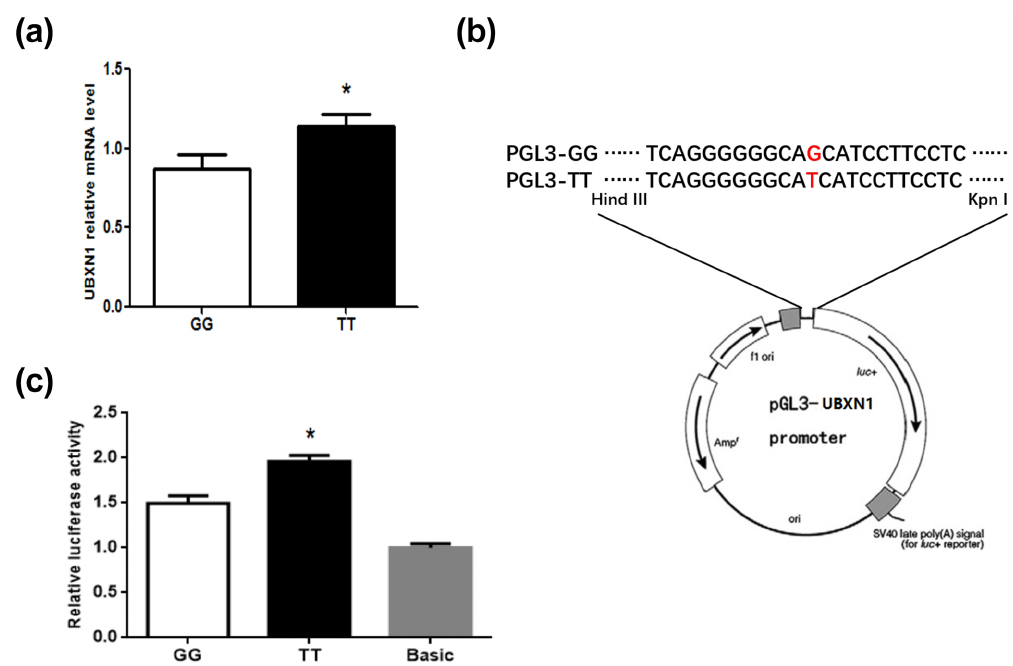
Figure 4. The UBXN1 expression and transcriptional activity in individuals with GG and TT genotypes. (a) UBXN1 mRNA level of GG ( n = 9) and TT ( n = 9) genotypes in porcine longissimus dorsi muscle. ∗ P< 0 . 05. (b) Schematic illustration of the pGL3-GG/TT-promoter constructs. (c) Transcriptional activity analysis of pGL3-GG and pGL3-TT-promoter reporter vectors in 293T cells. The data shown in figures are arithmetic means ± standard error of the mean (SEM). n = 3 for each group. ∗ P< 0 . 05.